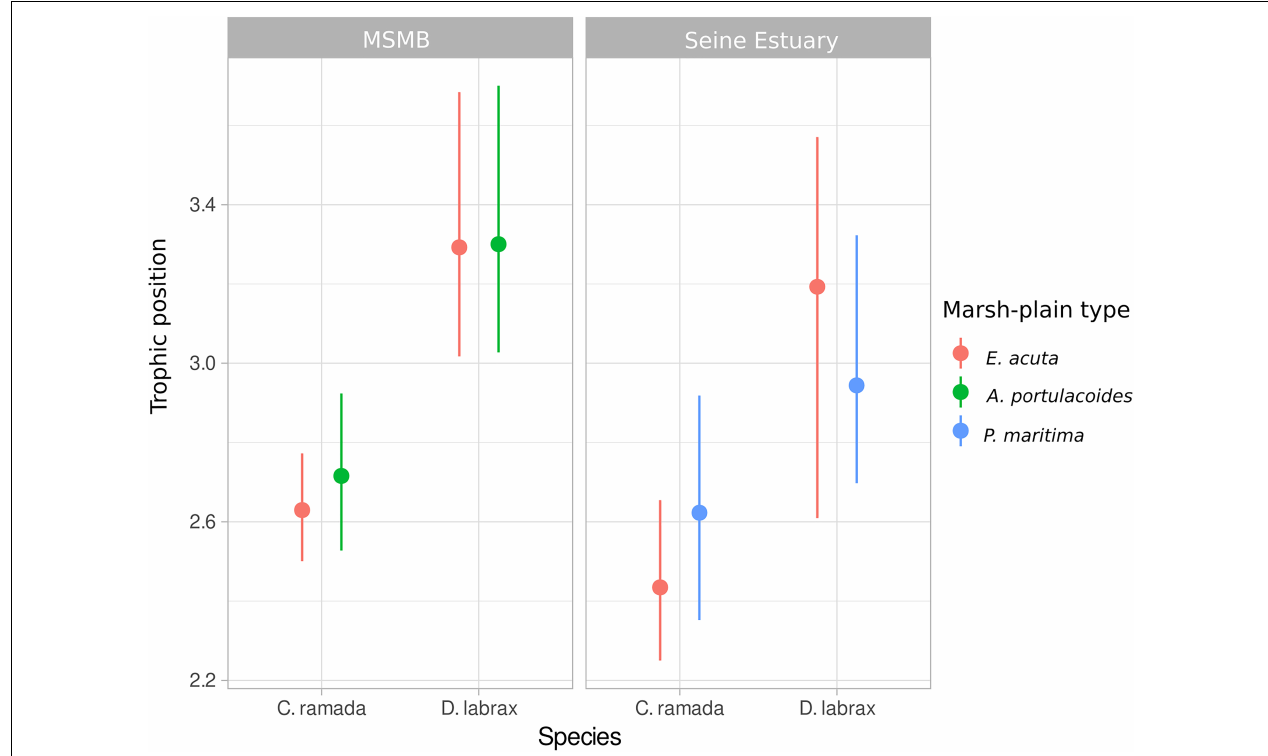
FIGURE 6 | Median and 95% CI of posterior trophic position for each fish species according to marsh-plain type. MSMB, Mont-Saint-Michel Bay, C. ramada, Chelon ramada ; D. labrax, Dicentrarchus